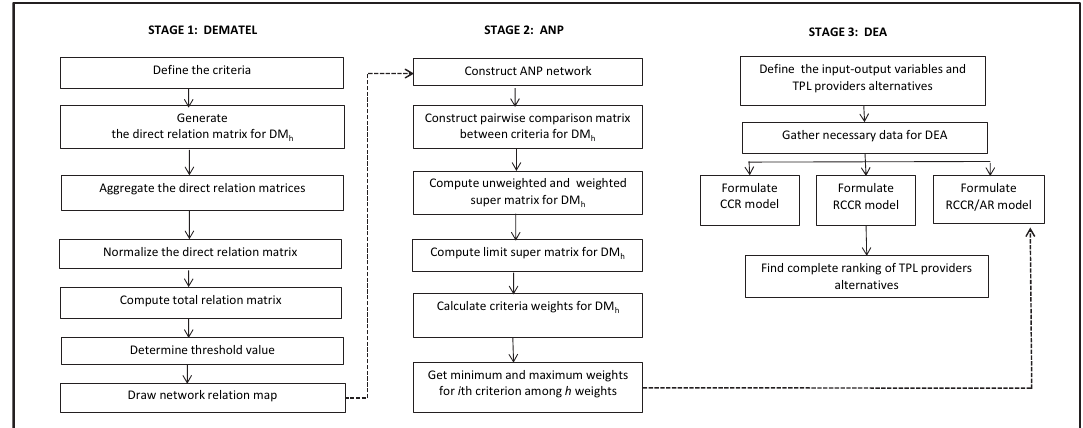
Fig. 3. The integration of DEMATEL, ANP and